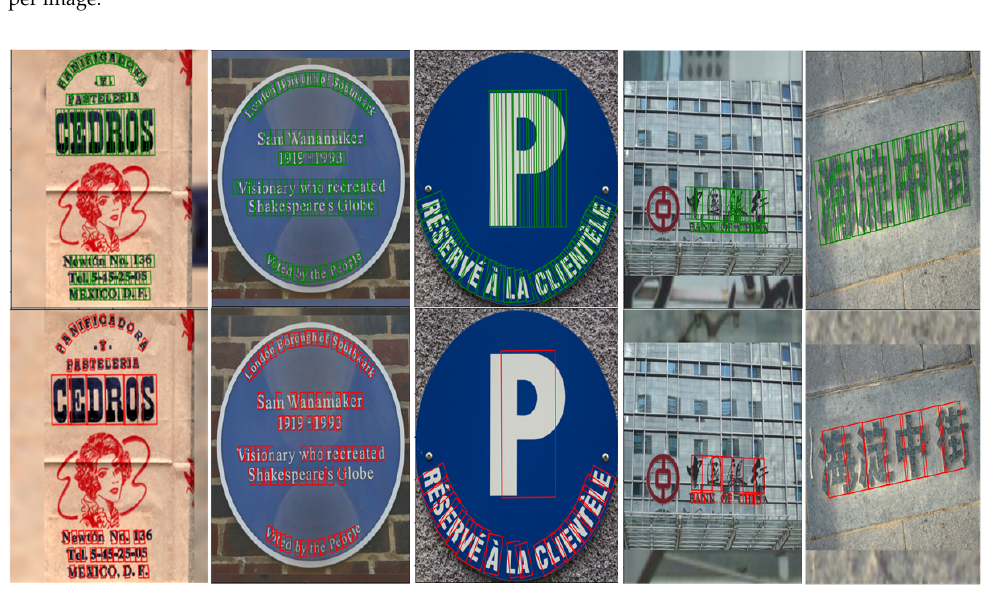
Figure 6. Comparative examples of the text component extraction results of our method and DRRG. The first row contains the text component instances extracted by our method, and the second row contains text component instances extracted by